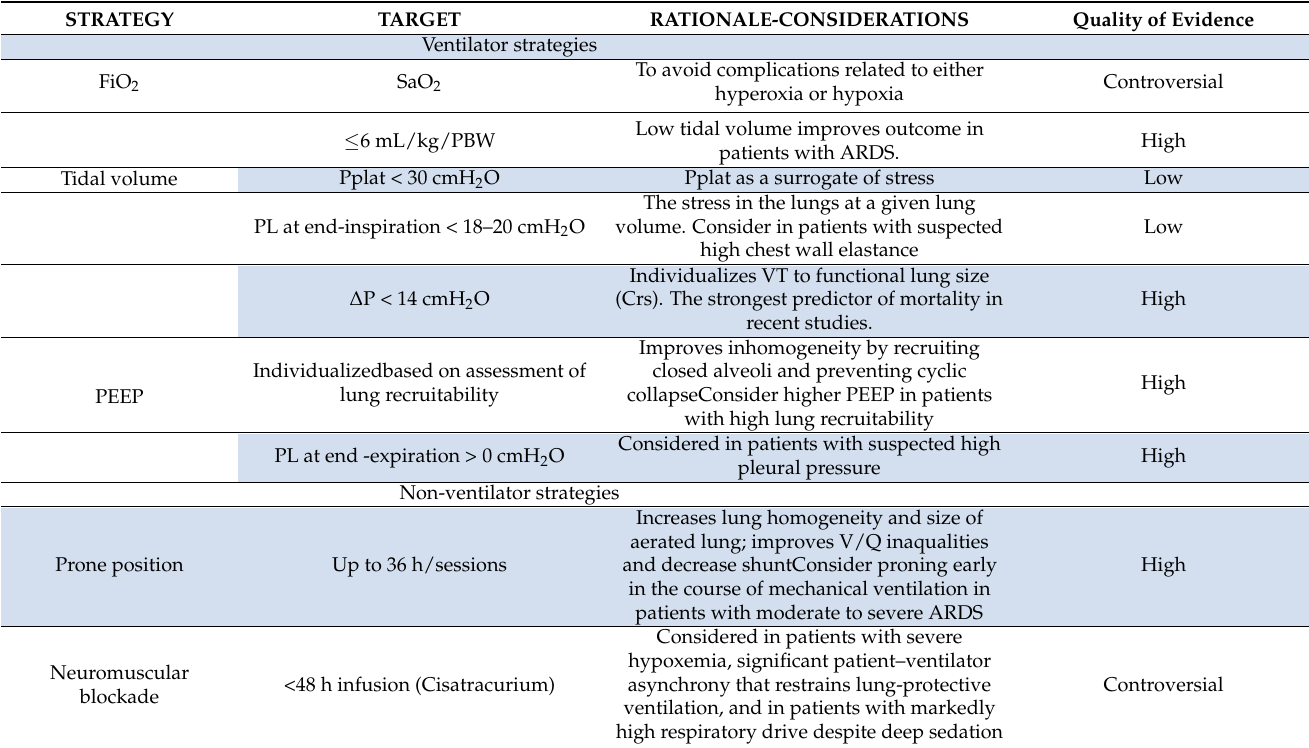
Table 1. Ventilator and non-ventilator strategies during controlled mechanical ventilation. STRATEGY TARGET RATIONALE-CONSIDERATIONS Quality of Evidence Ventilator strategies Controversial High Pplat as a surrogate of stress